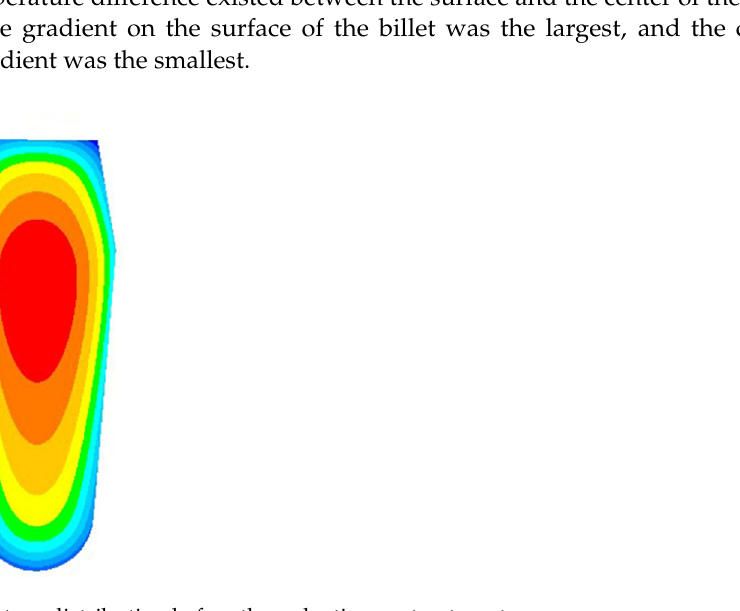
Figure 8. Temperature distribution before the reduction pretreatment.